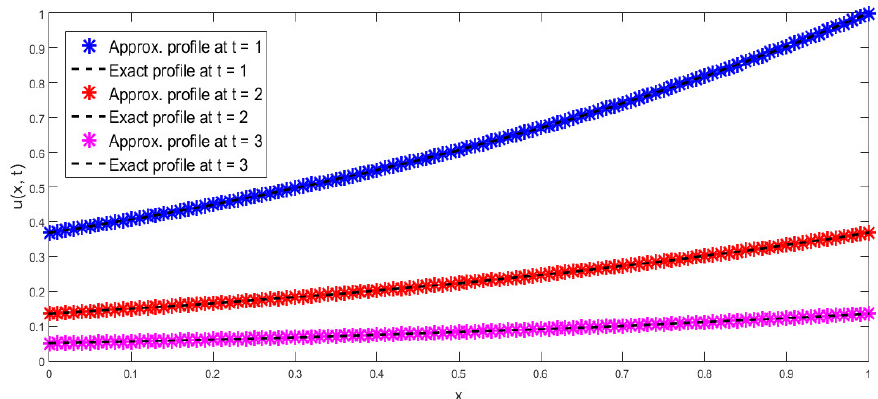
Figure 2. Comparison of approx. and exact profiles at t = 1, 2, 3 regarding Example 2.